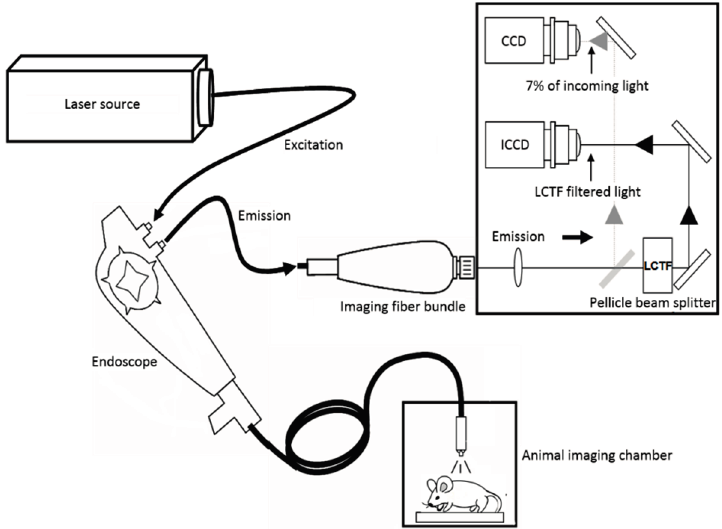
Figure 2. Schematic of the synchronous fluorescence imaging system. Adapted from